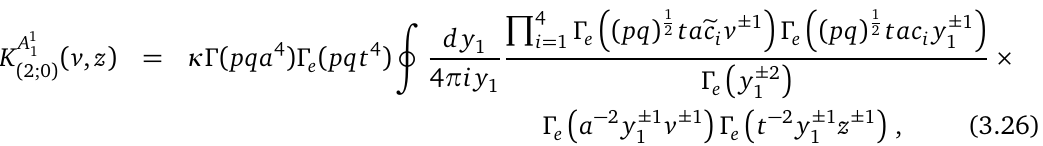
tube theory with SU ( 2 ) 1